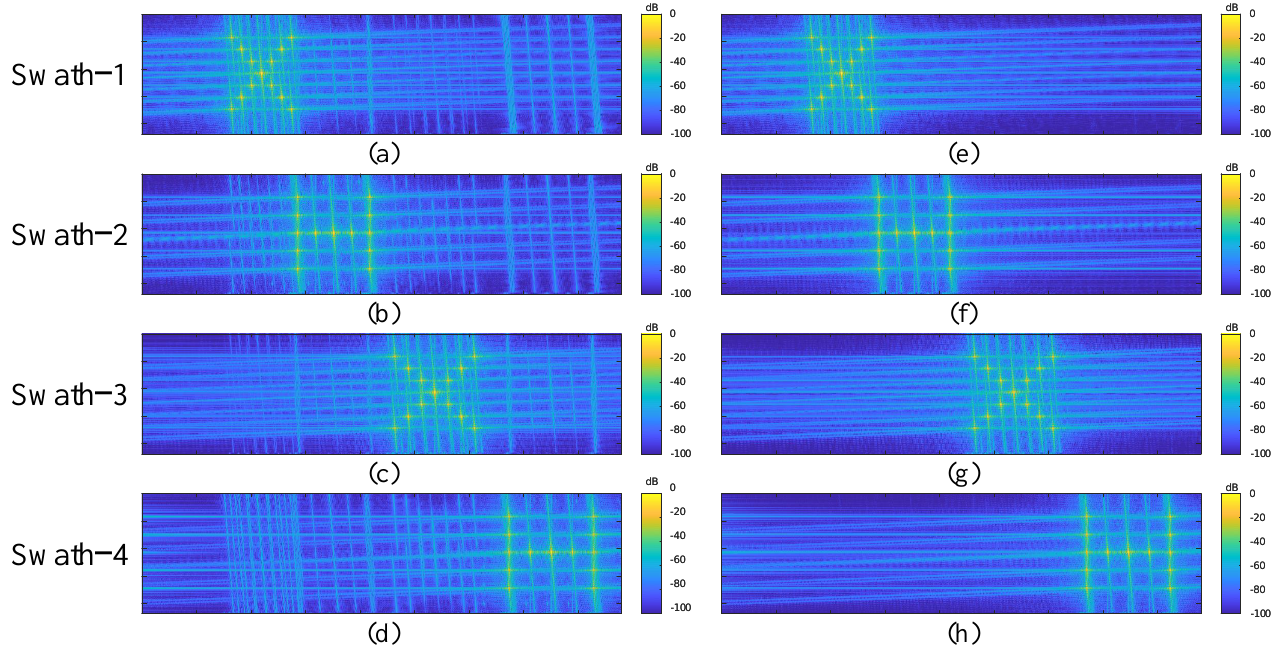
Figure 18. The 2D simulation results. ( a – d ) The 2D simulation results of the conventional single-null constrained scheme. ( e – h ) The 2D simulation results of the proposed multi-null constraint scheme.